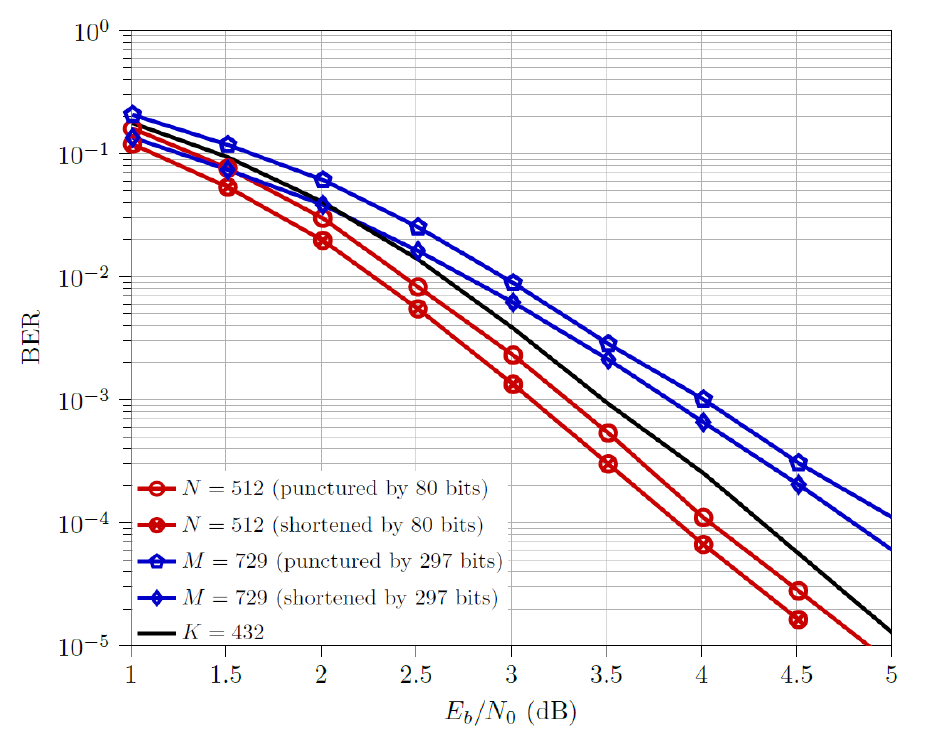
Figure 7. BER performance of Scenario 2 for R d =